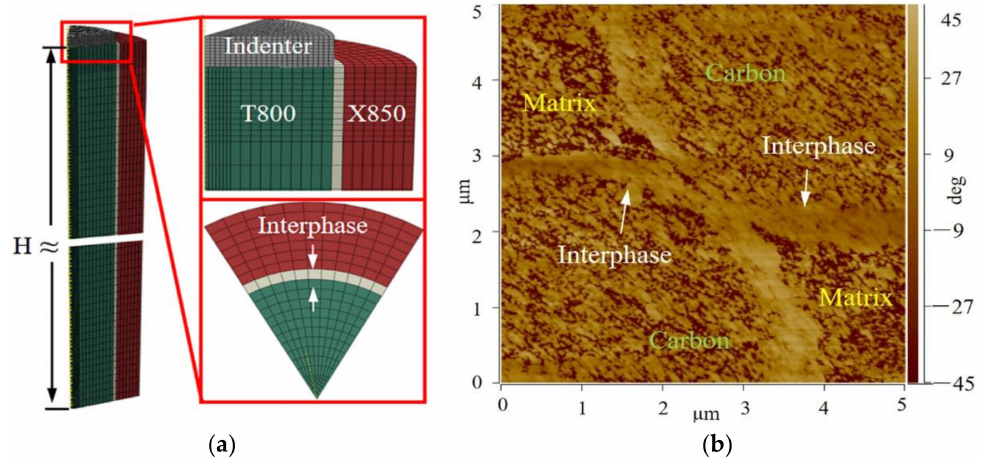
Figure 4. ( a ) Finite-element model for the push-out test, ( b ) atomic force microscopy (AFM) images of composite interface